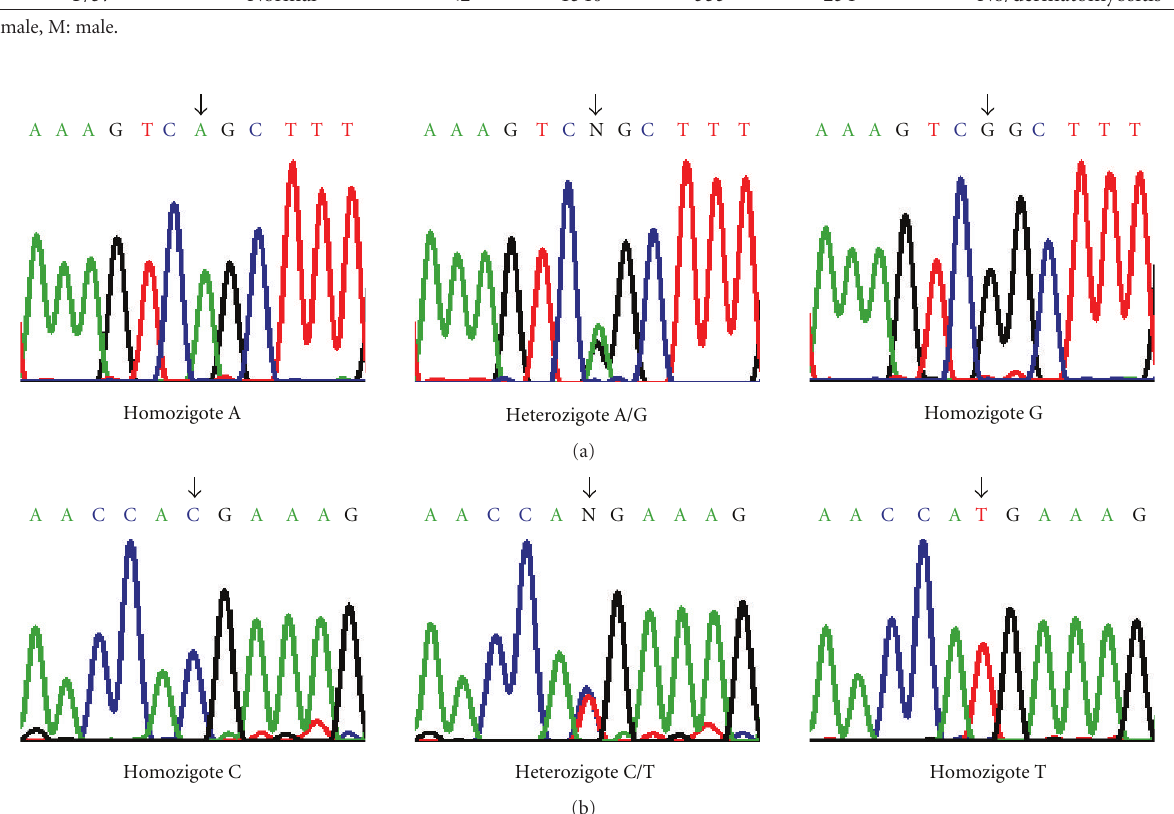
Figure 1: Sequencing analysis of regions 2 and 4 from human AICDA gene, where genetic variants were detected by heteroduplex. Panels show sequences of the di ff erent alleles corresponding to 5923A/G polymorphism at the 3 (cid:2) -flanking region of (a) exon 2 and 7888C/T polymorphism at (b) exon 4 of the AICDA gene. Arrows indicate the polymorphic